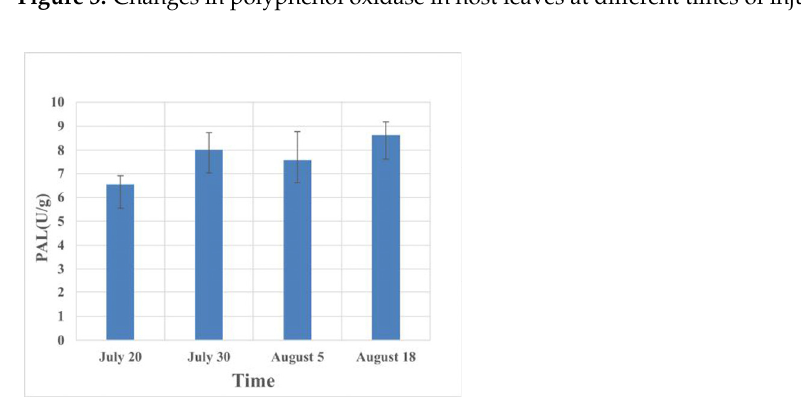
Figure 3. Changes in polyphenol oxidase in host leaves at different times of injury. Table 4. Measuring phenylalanine ammonia lyase in host leaves at different times of injury. Time